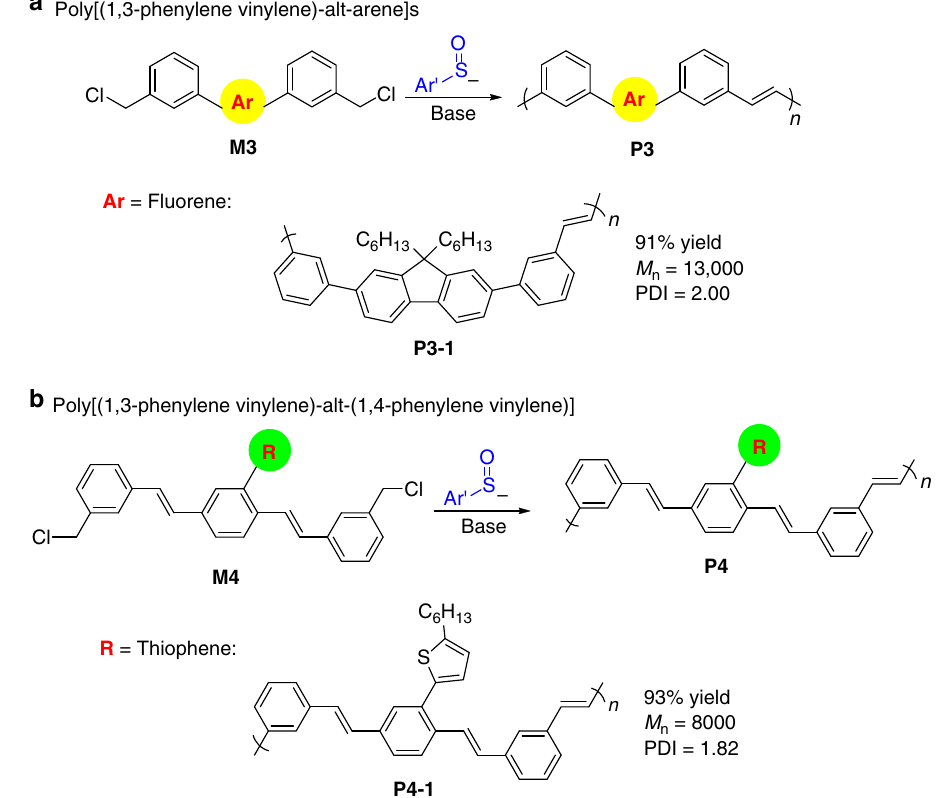
Fig. 6 Design and synthesis of alternating co-polymers. a Poly[(1,3-phenylene vinylene)-alt-arene]s. b Poly[(1,3-phenylene vinylene)-alt-(1,4-phenylene vinylene)] (P m PV p